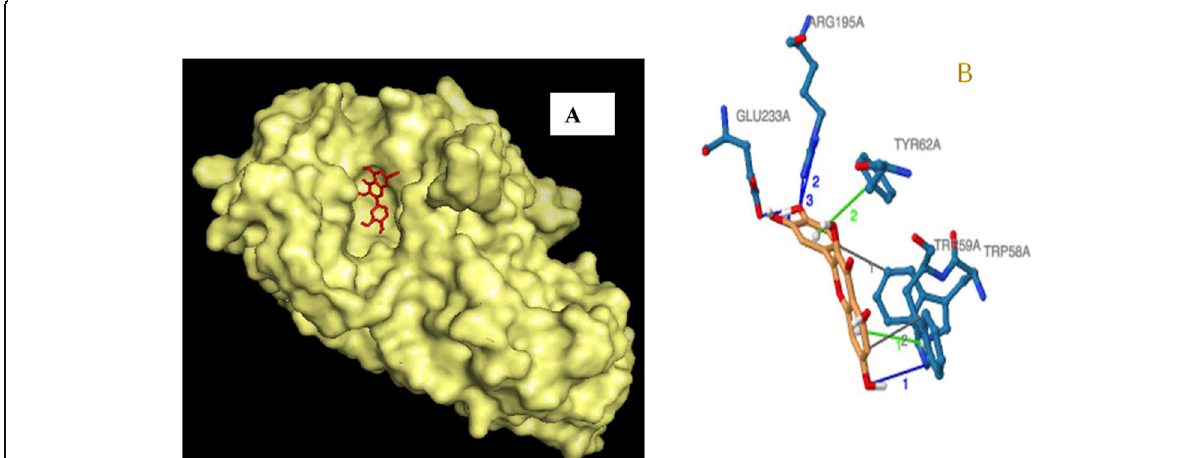
Fig. 12 Binding pose and binding site of quercetin with α -amylase (panel A), molecular interaction of quercetin with amino acid residues within the binding pocket of the protein structure (panel